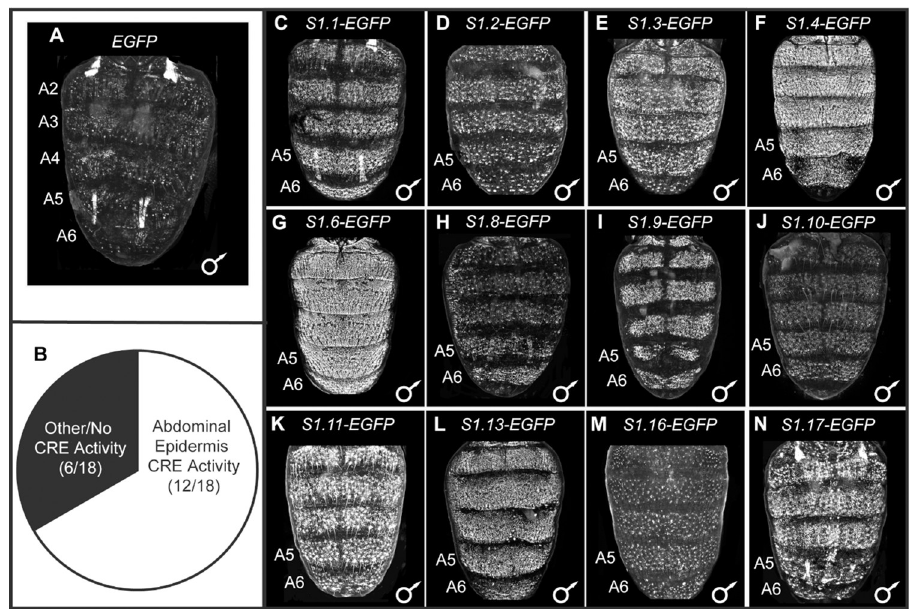
Fig 2. Reporter transgene test of 18 predicted CREs from the first dorsal pupal abdomen CRE training set. (A and C-N) EGFP reporter transgene expressions in the dorsal abdomens of male D . melanogaster pupa at ~80–88 hours after puparium formation (hAPF) or the P13-P14(i) developmental stage. Expressions in the female abdomens were similar and therefore not reported here. (A) In the absence of a CRE, EGFP expression was seen in some abdominal muscles, but little to no expression was seen in the abdominal epidermis. (B) Of the 18 pCREs tested by reporter transgene assays, twelve showed reproducible dorsal abdominal epidermis expression that exceeds what is observed in the (A) no CRE control. (C-N) Among the pCREs with abdominal expression regulatory activity, EGFP expression was generally seen throughout abdominal segments A2-A6. All reporter transgenes were inserted into the 51D att P site on the 2 nd chromosome, and therefore experience the same genomic and chromatin environments. (J) Brightness was increased in Adobe Photoshop by 25% compared to the other figure panels with EGFP expressions.